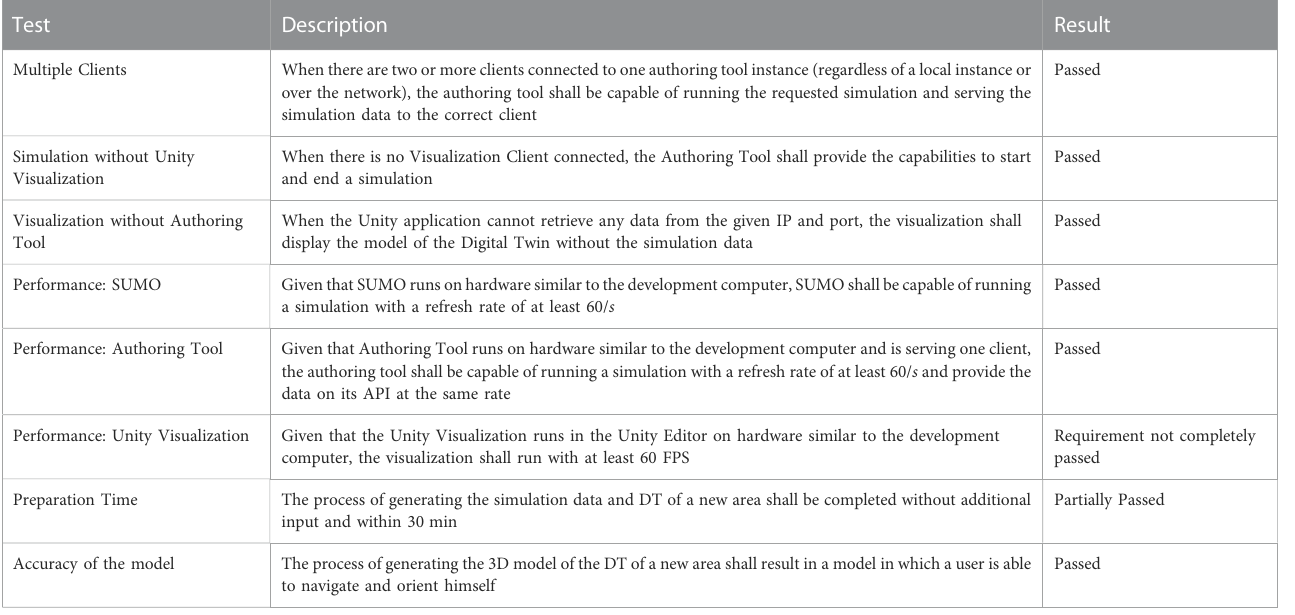
TABLE 1 Integration tests applied during the creation of the area or on the result of this